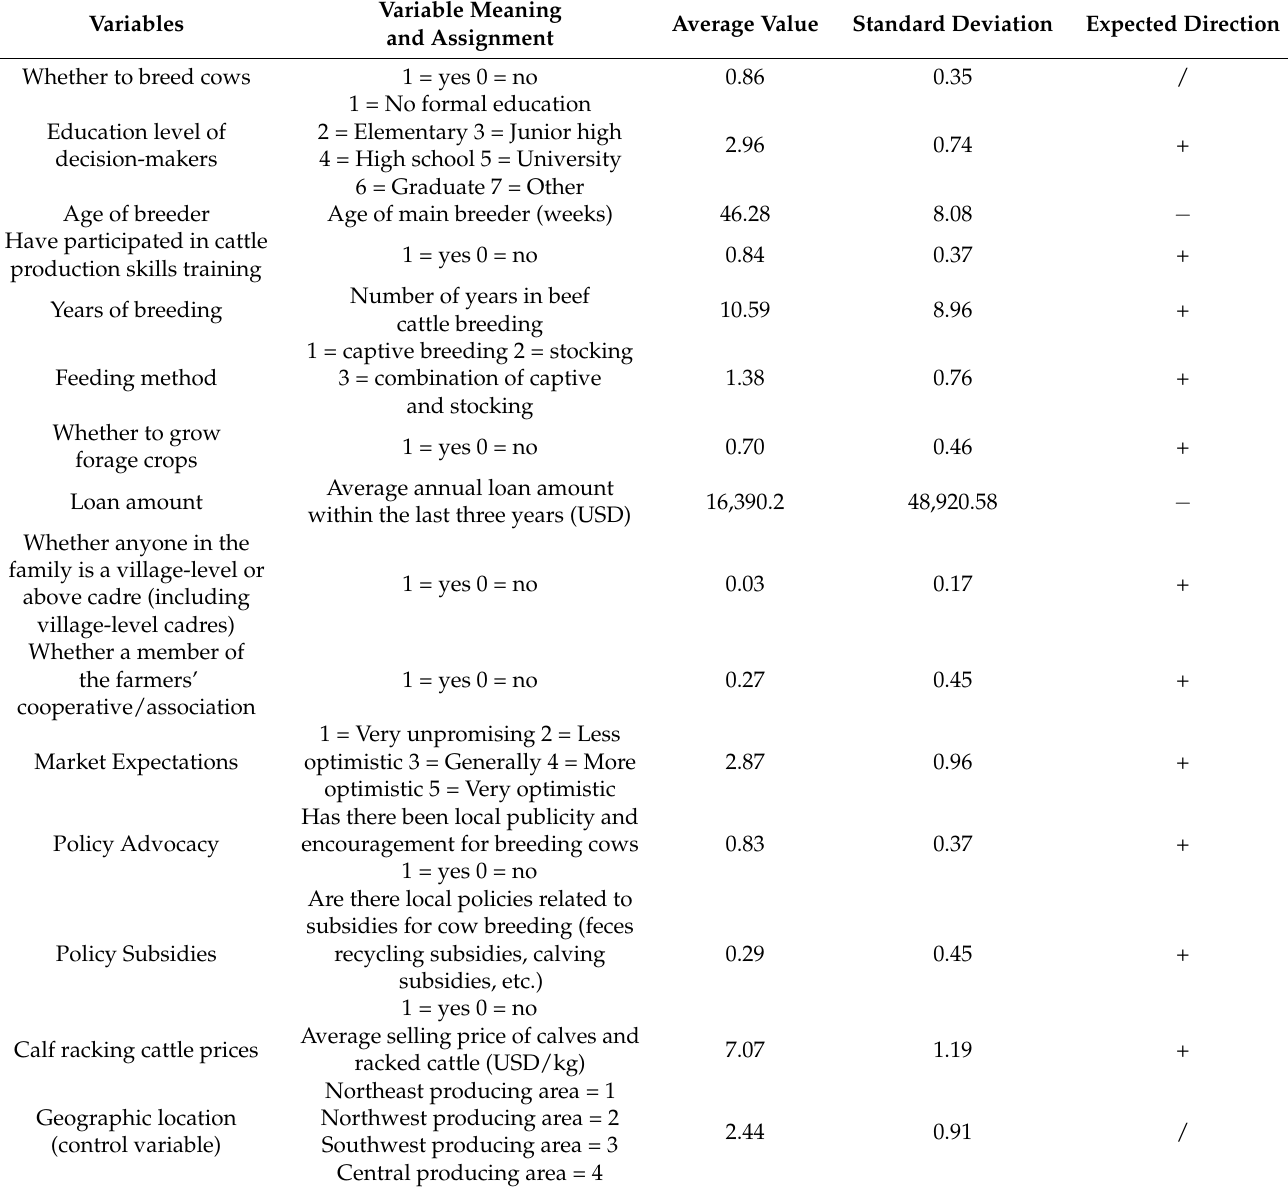
Table 2. Definition and descriptive statistics of each variable of the